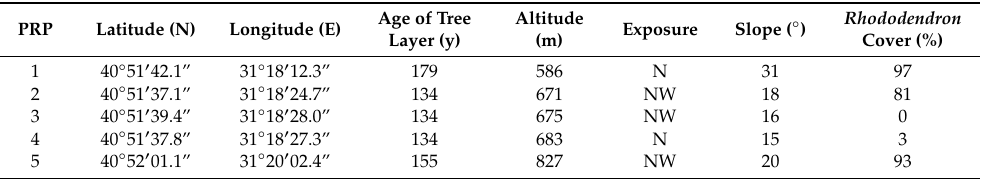
Table 1. Basic stand and site characteristics of the permanent research plots (PRP) with Fagus orientalis Lipsky forest stands in the Düzce province in the Black Sea Region of